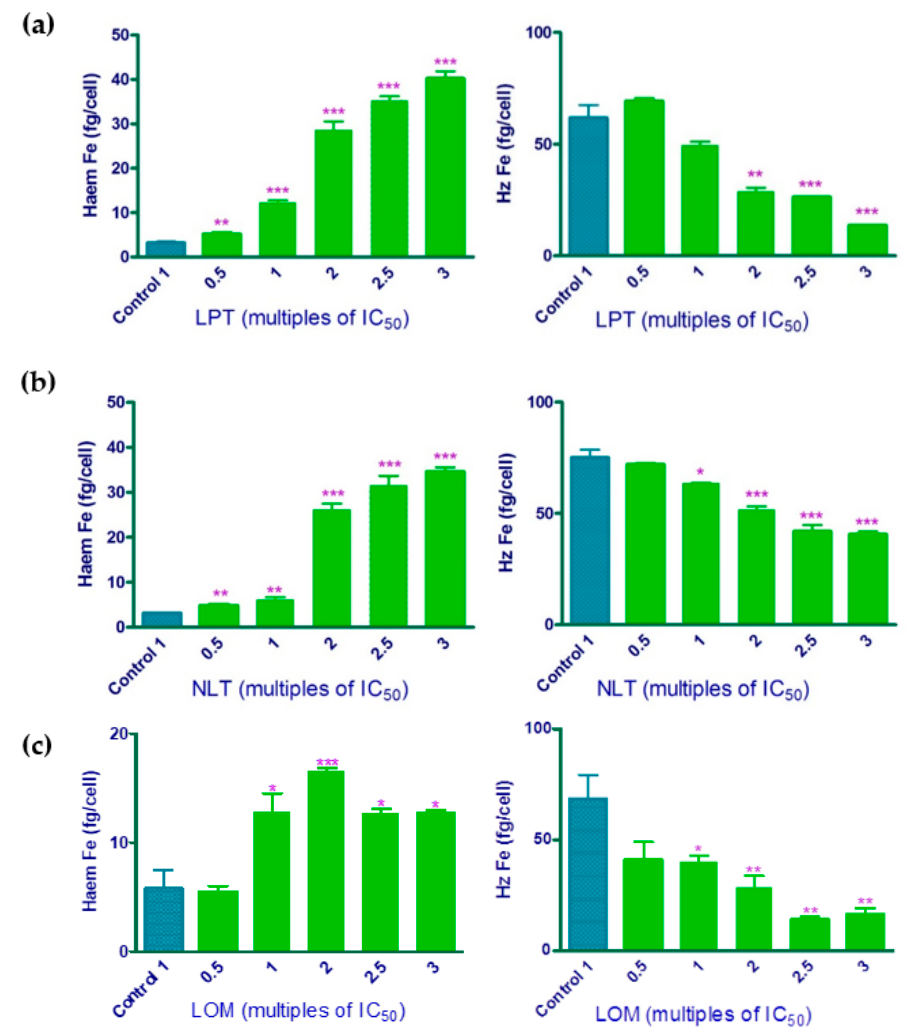
Figure 2. Freely exchangeable haem (left panels) and haemozoin (Hz, right panels) expressed as fg haem iron per trophozoite in isolated P. falciparum trophozoites following 32 h incubation with ( a ) lapatinib (LPT), ( b ) nilotinib (NLT), and ( c ) lomitapide (LOM) at multiples of their IC 50 . Control: untreated cells. * p < 0.05; ** p < 0.01; *** p < 0.001.